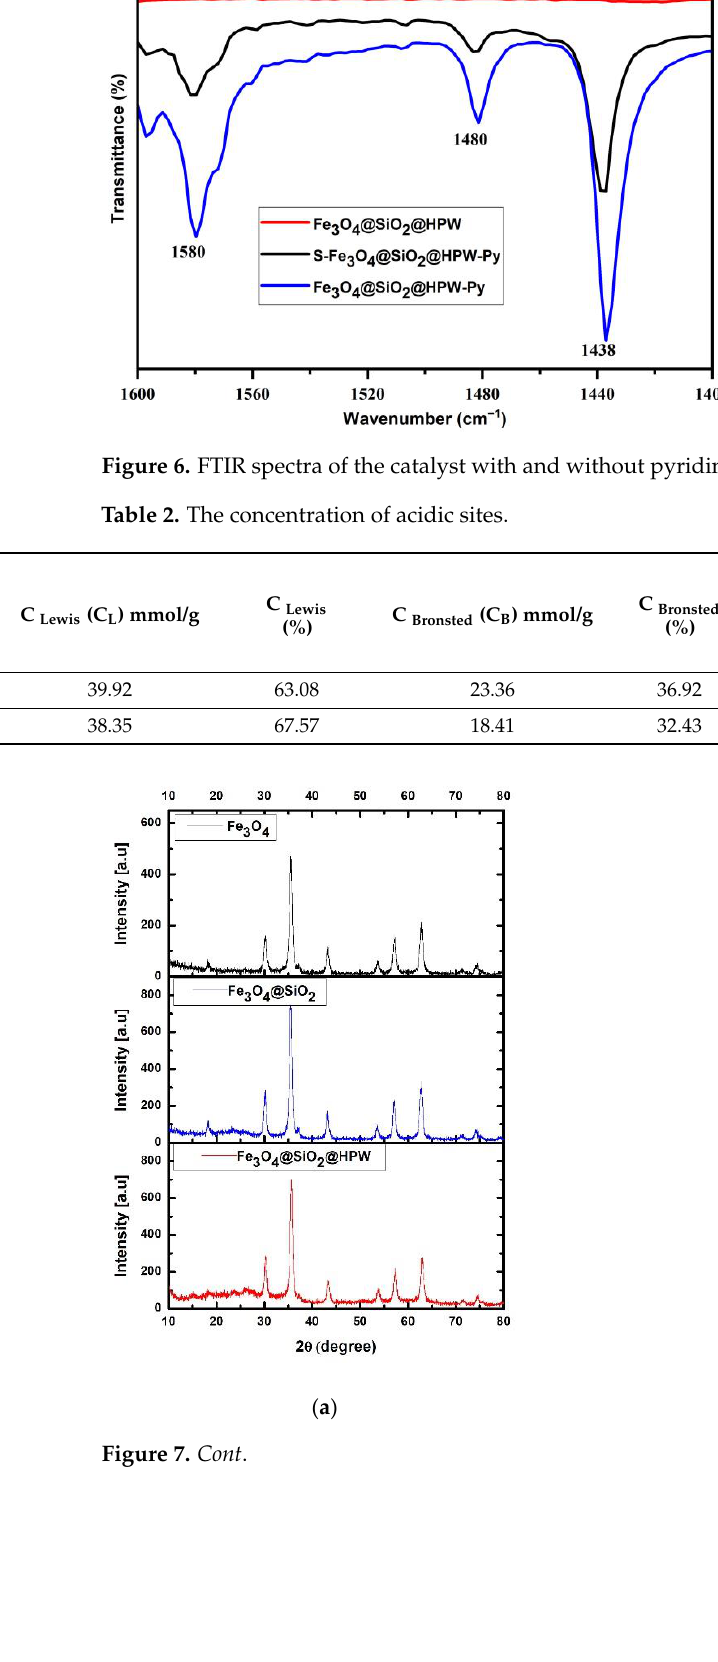
( b ) Figure 7. XRD patterns of Fe 3 O 4 , Fe 3 O 4 @ SiO 2 , and Fe 3 O 4 @ SiO 2 @HPW ( a ) 2θ = 10–80°; ( b ) 2θ = 10– 30° . Figure 8 displays the N 2 adsorption-desorption isotherms for the Fe 3 O 4 , Fe 3 O 4 @SiO 2, and Fe 3 O 4 @SiO 2 @HPW catalysts. In the silica-coated magnetite samples, Fe 3 O 4 @SiO 2 and Fe 3 O 4 @SiO 2 @HPW, the nitrogen adsorption-desorption isotherms present type IV